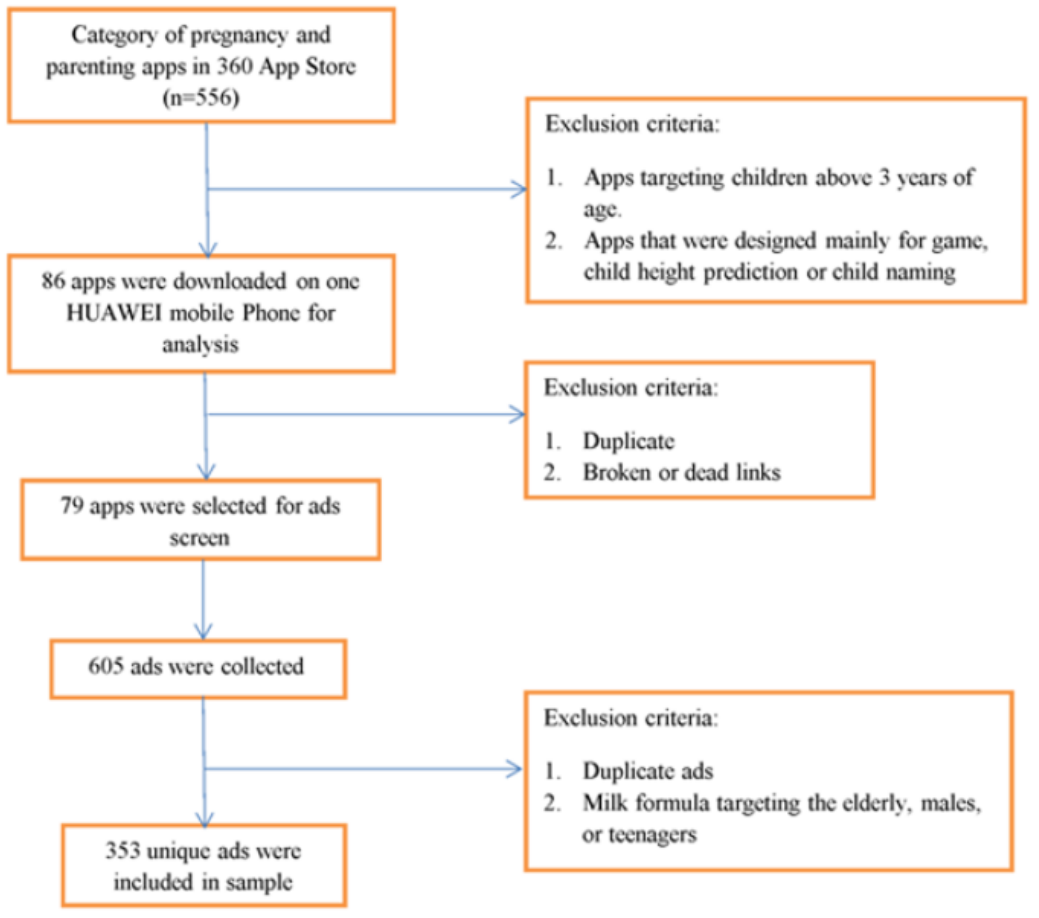
Figure 1. Flow chart for milk formula ads